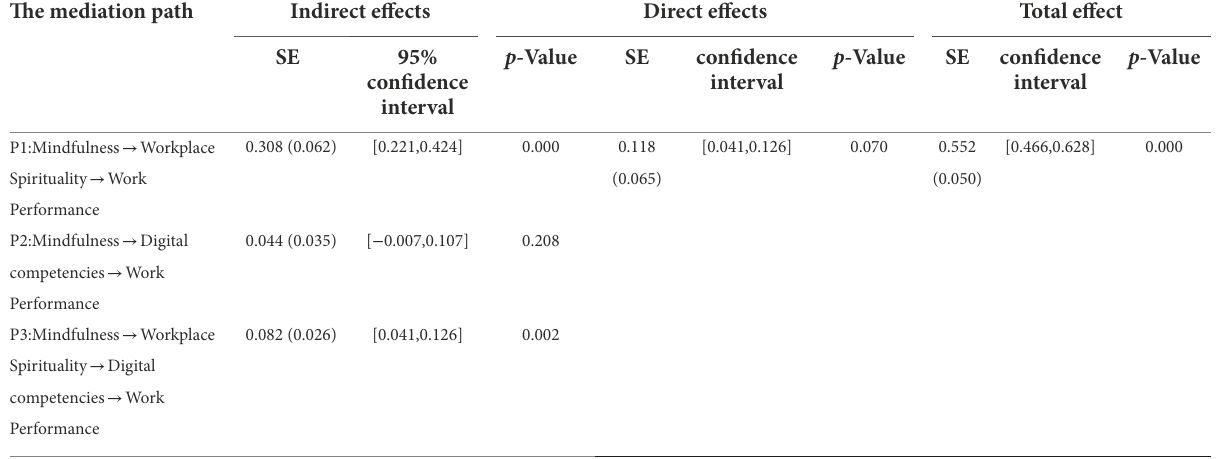
TABLE 7 Mediating effect test. The mediation